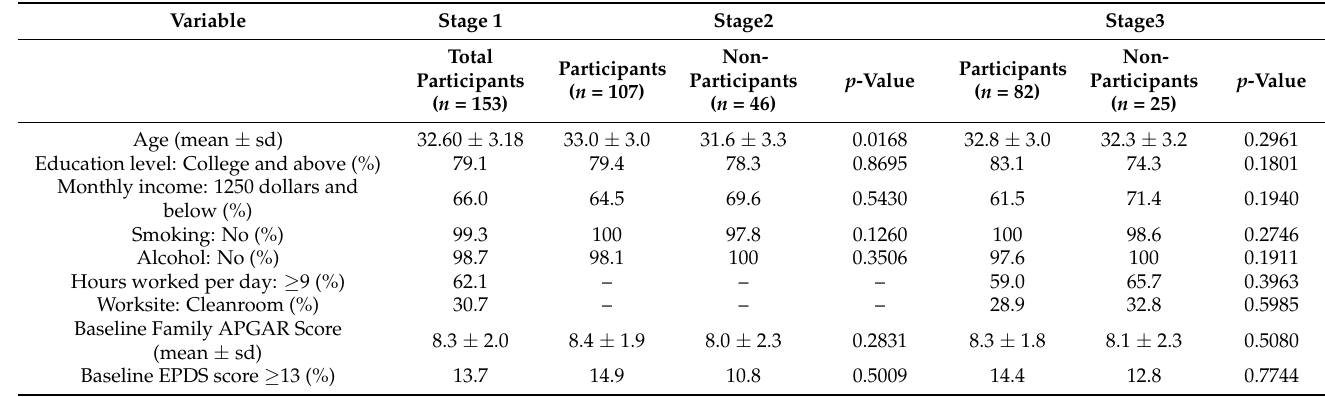
Table 1. Descriptive baseline characteristics of participants in the third trimester of pregnancy, at 3 weeks after childbirth, and at 1 month after returning to work.